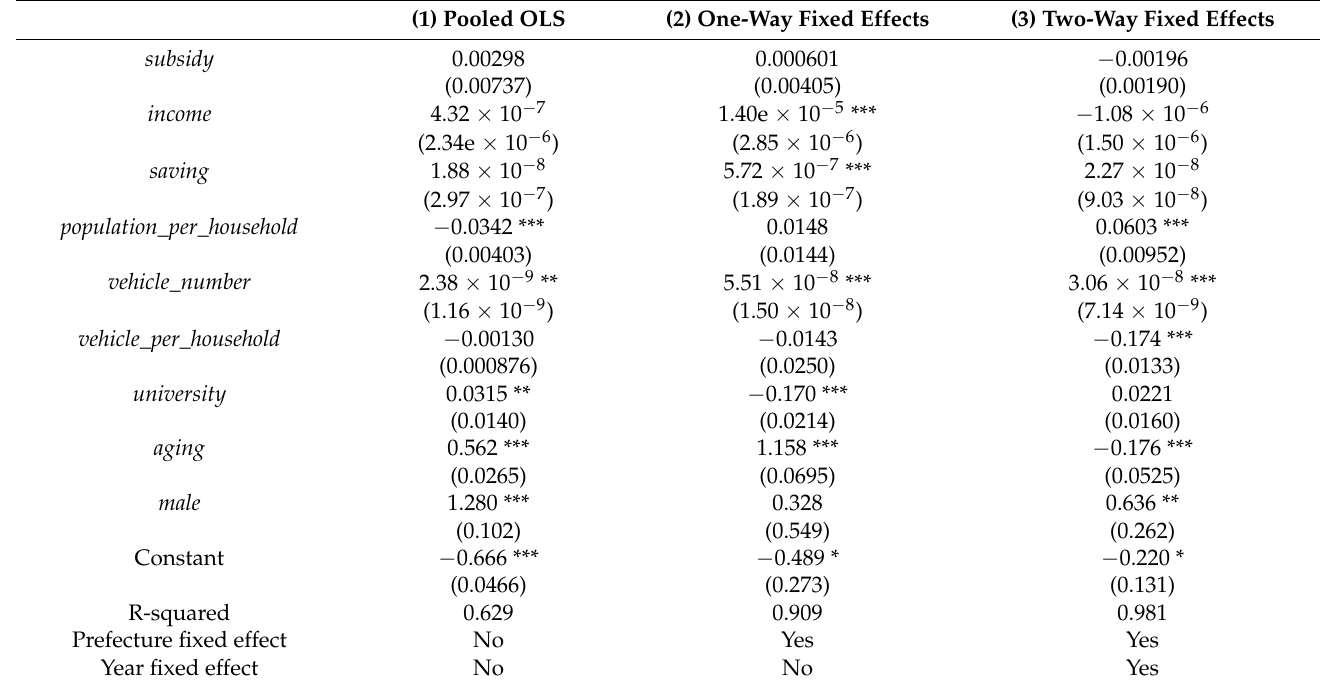
Table 3. Results of the panel data regression analysis.